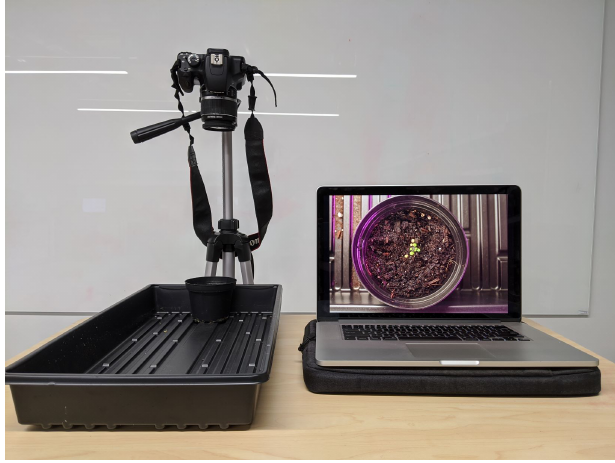
Figure 4. Data ingest